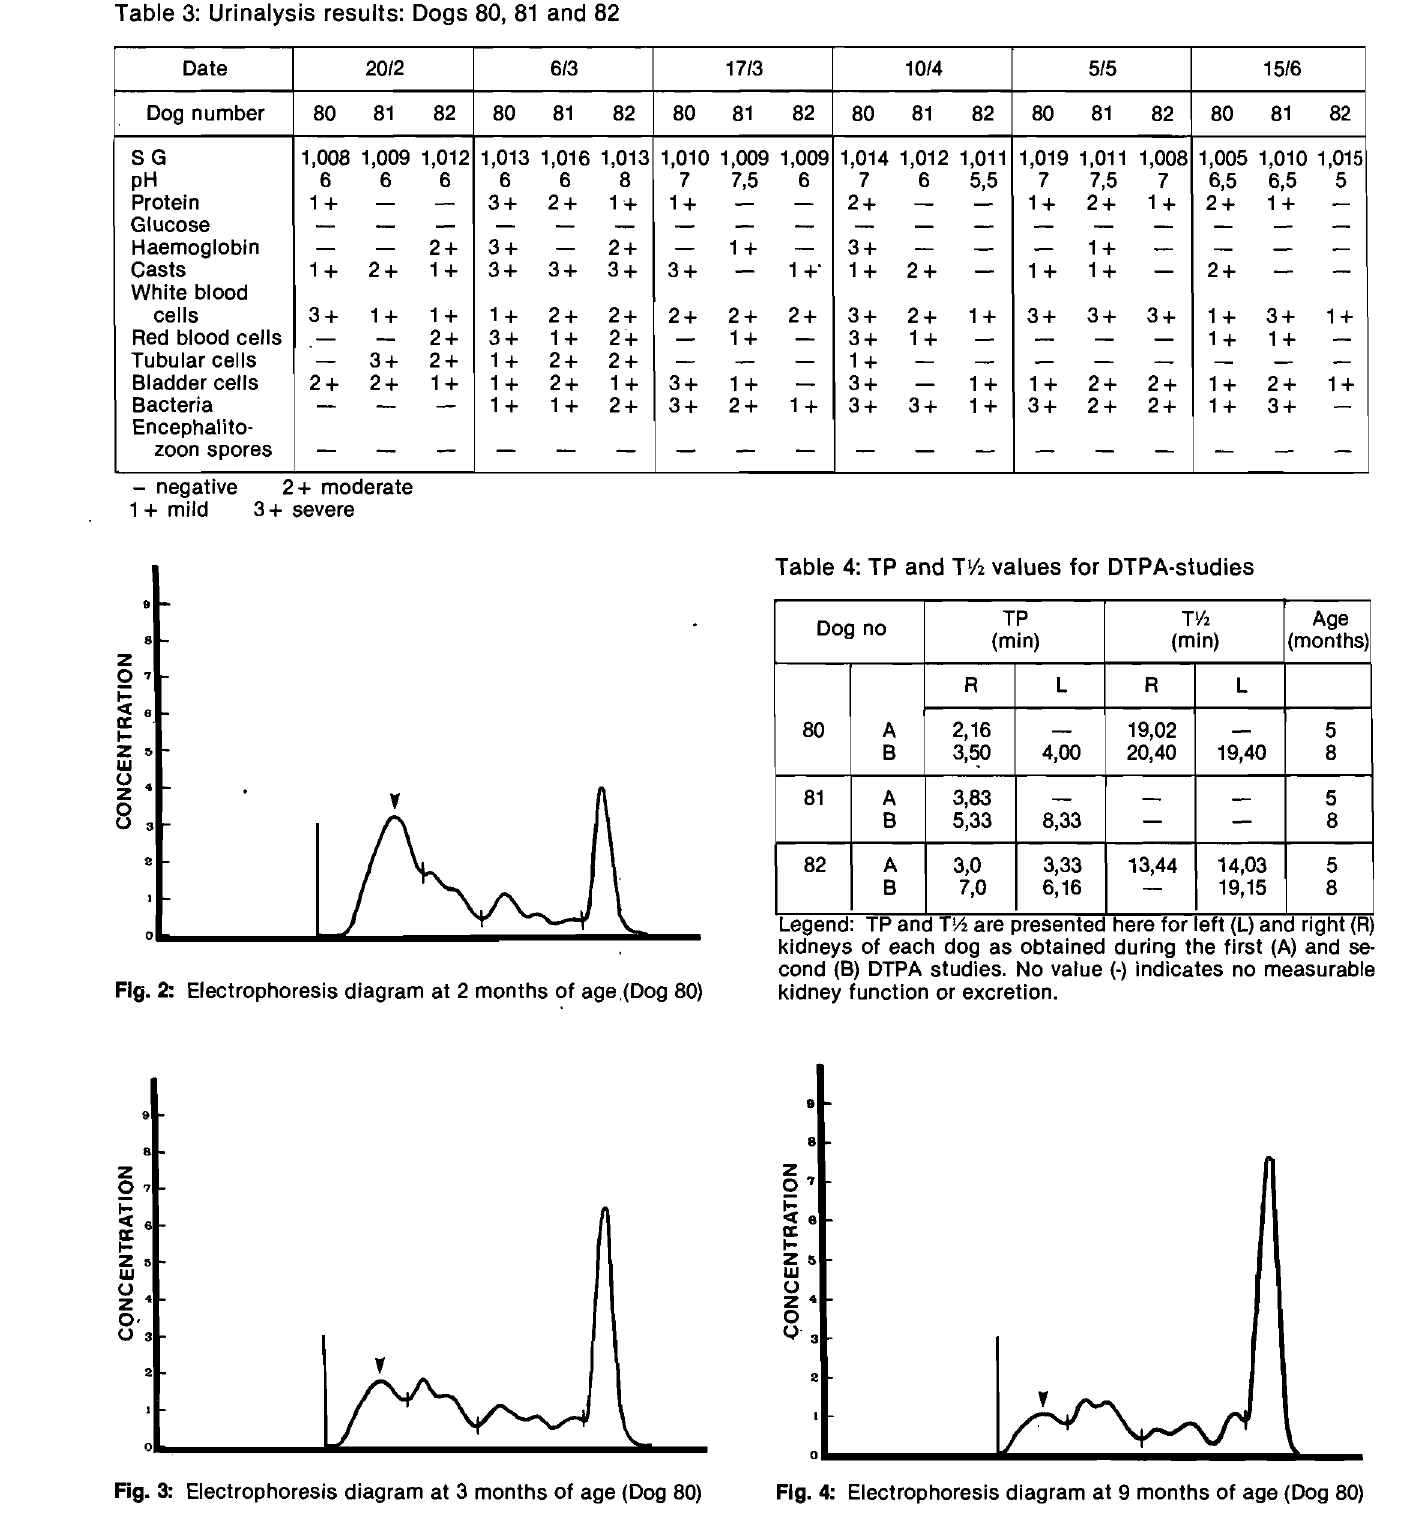
Fig. 4: Electrophoresis diagram at 9 months of age (Dog 80)